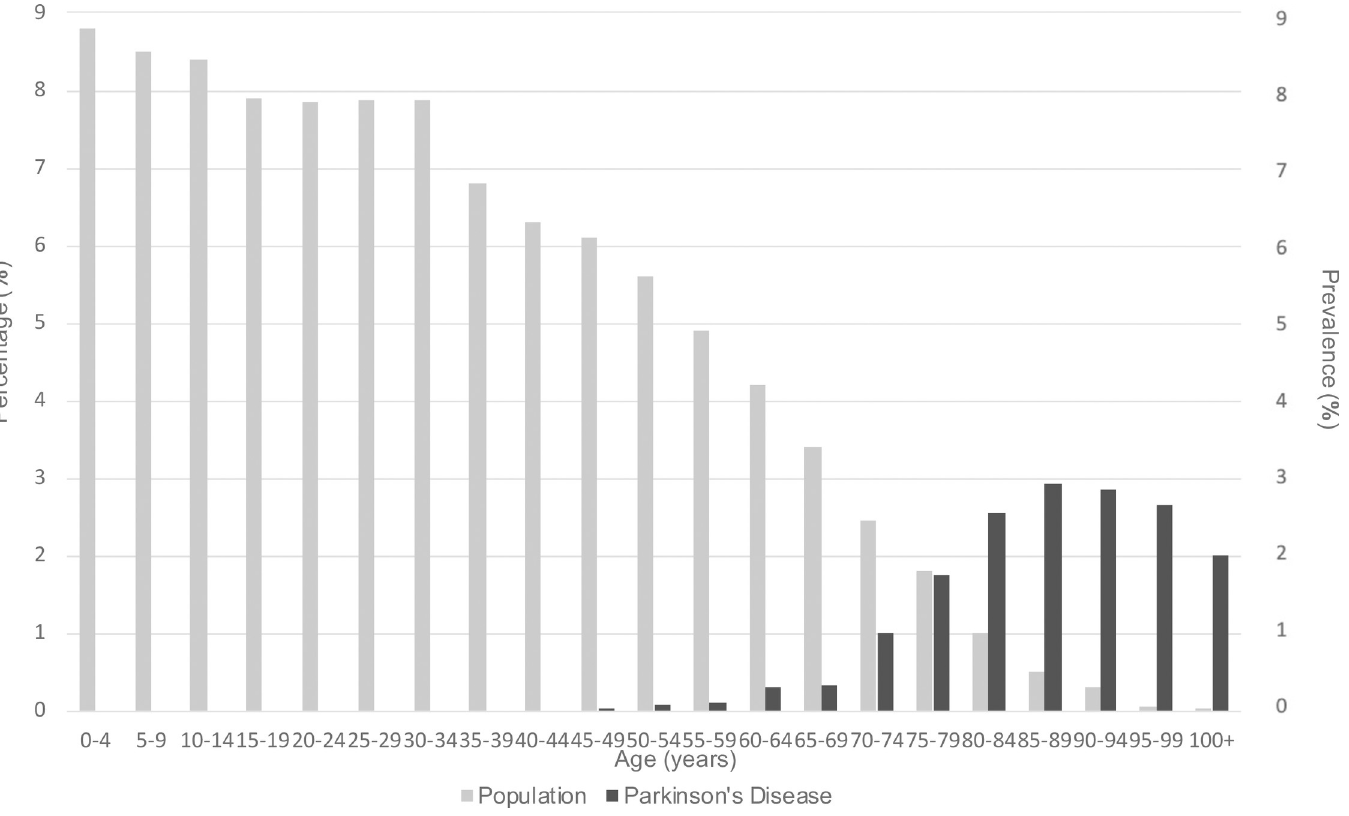
Fig 1. Distribution of the global population in 2020 [4] and prevalence of global Parkinson’s disease in 2016, by age [5]. The total world population amounts to 7,794,798,729. Prevalence is expressed as the percentage of the population that is affected by the disease.